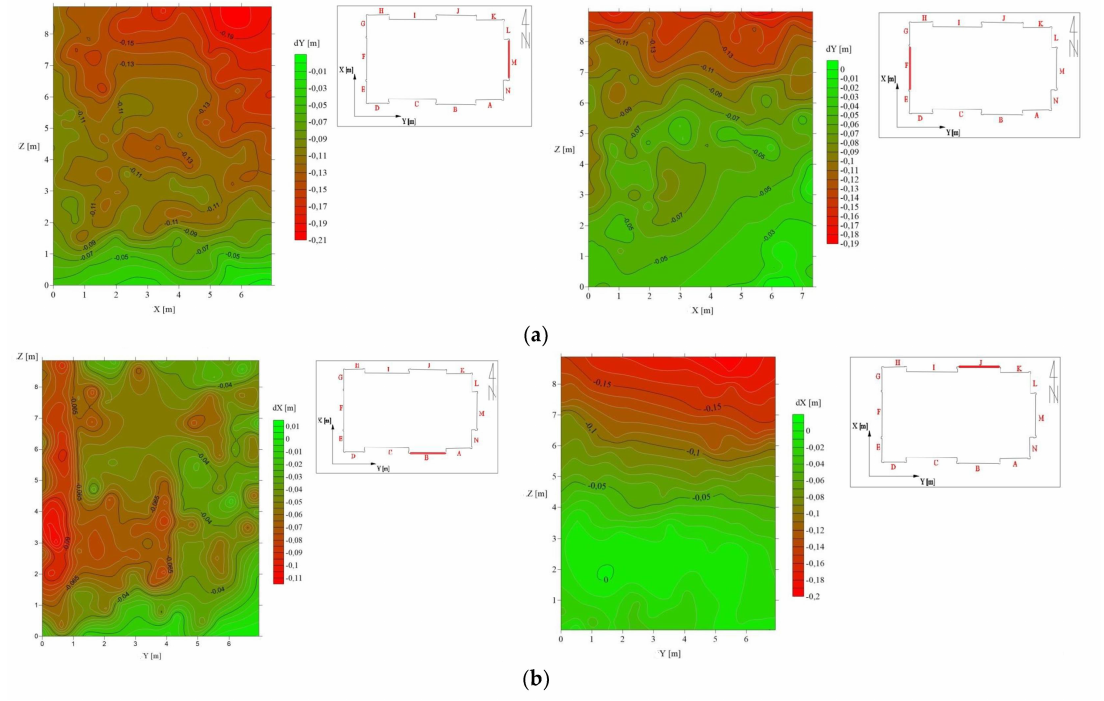
Figure 10. Deviations from the vertical planes of the external walls of the structure—( a ) walls ”M“ and “F” on the west-east axis and ( b ) walls ”B“ and “J” on the north-south